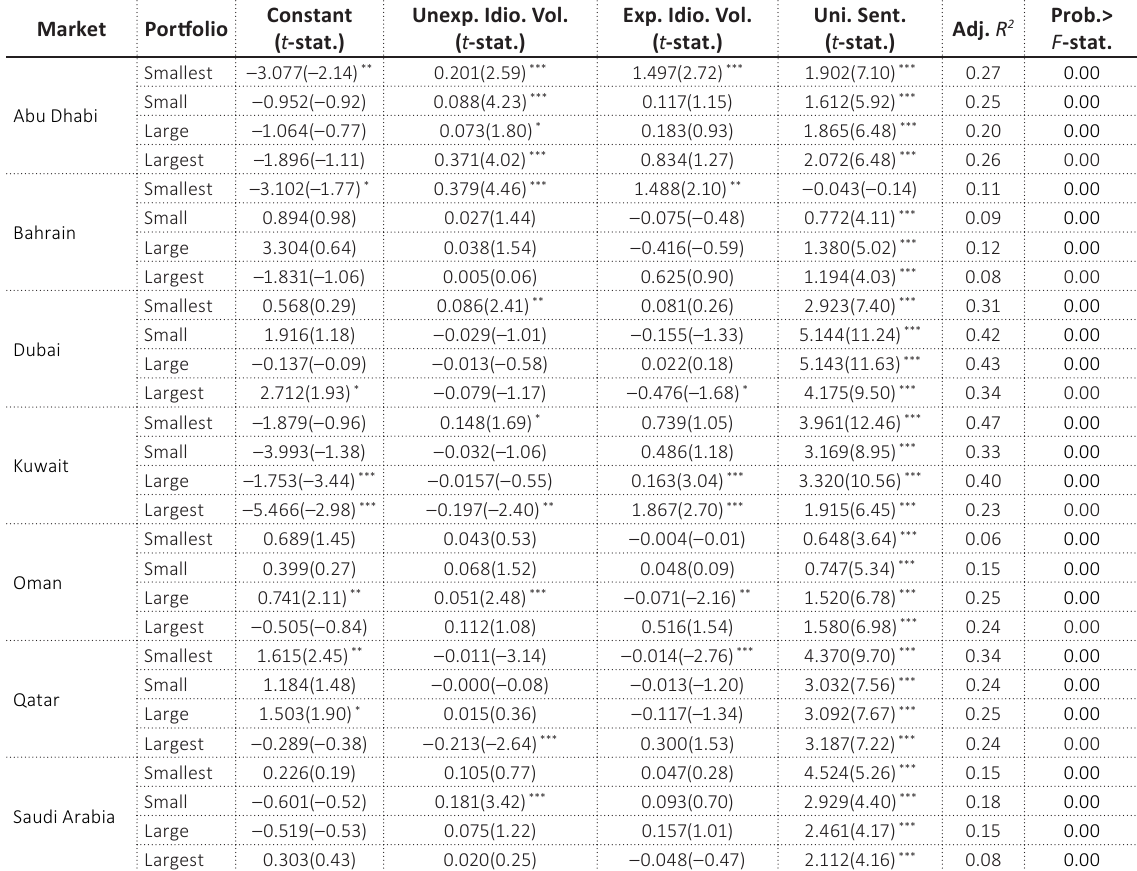
Table 5. Impact of expected and unexpected idiosyncratic volatility and sentiment on size-portfolio